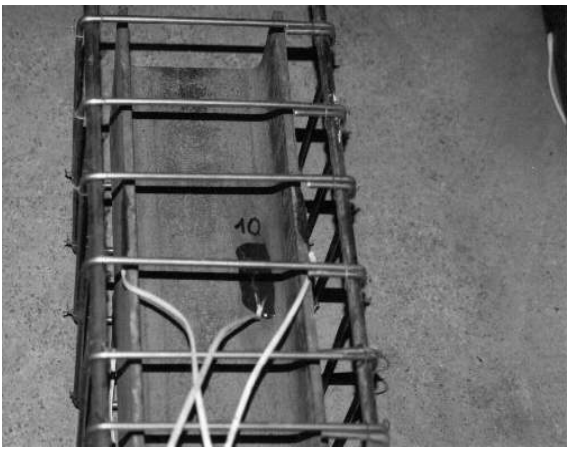
Fig 3 . The construction steel and bars prepared to encased